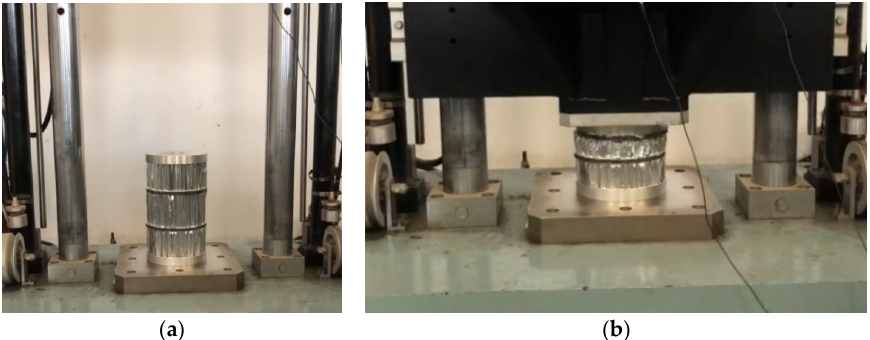
Figure 13. Impact test of AH combination in series. ( a ) Preparation for impact test; ( b ) Impact test completed.